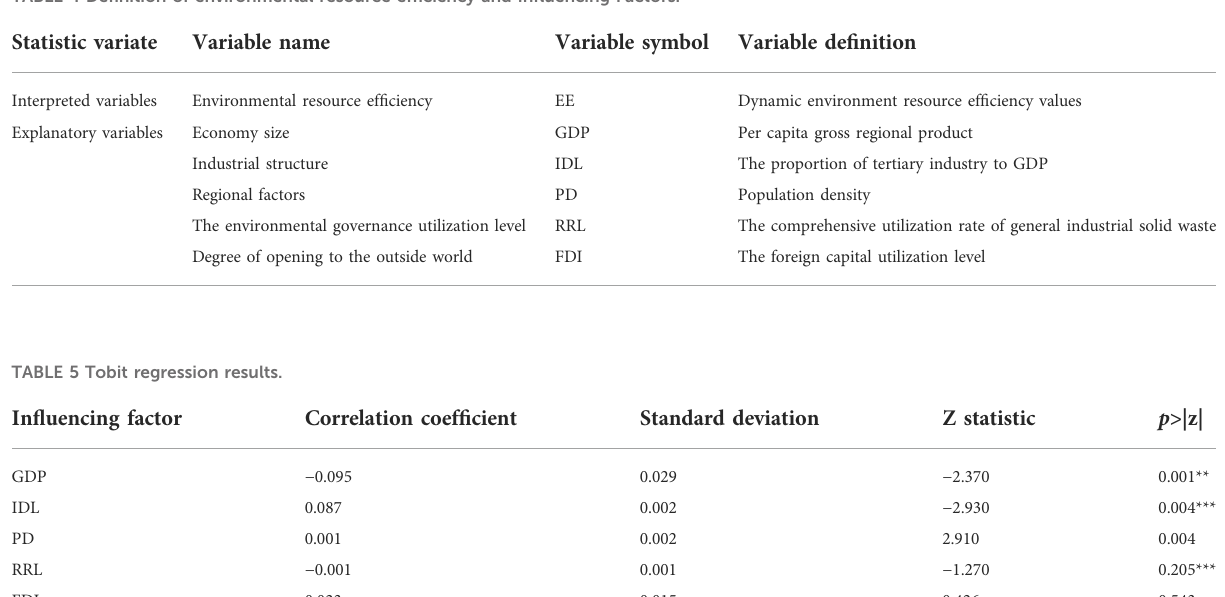
TABLE 4 De fi nition of environmental resource ef fi ciency and In fl uencing Factors.